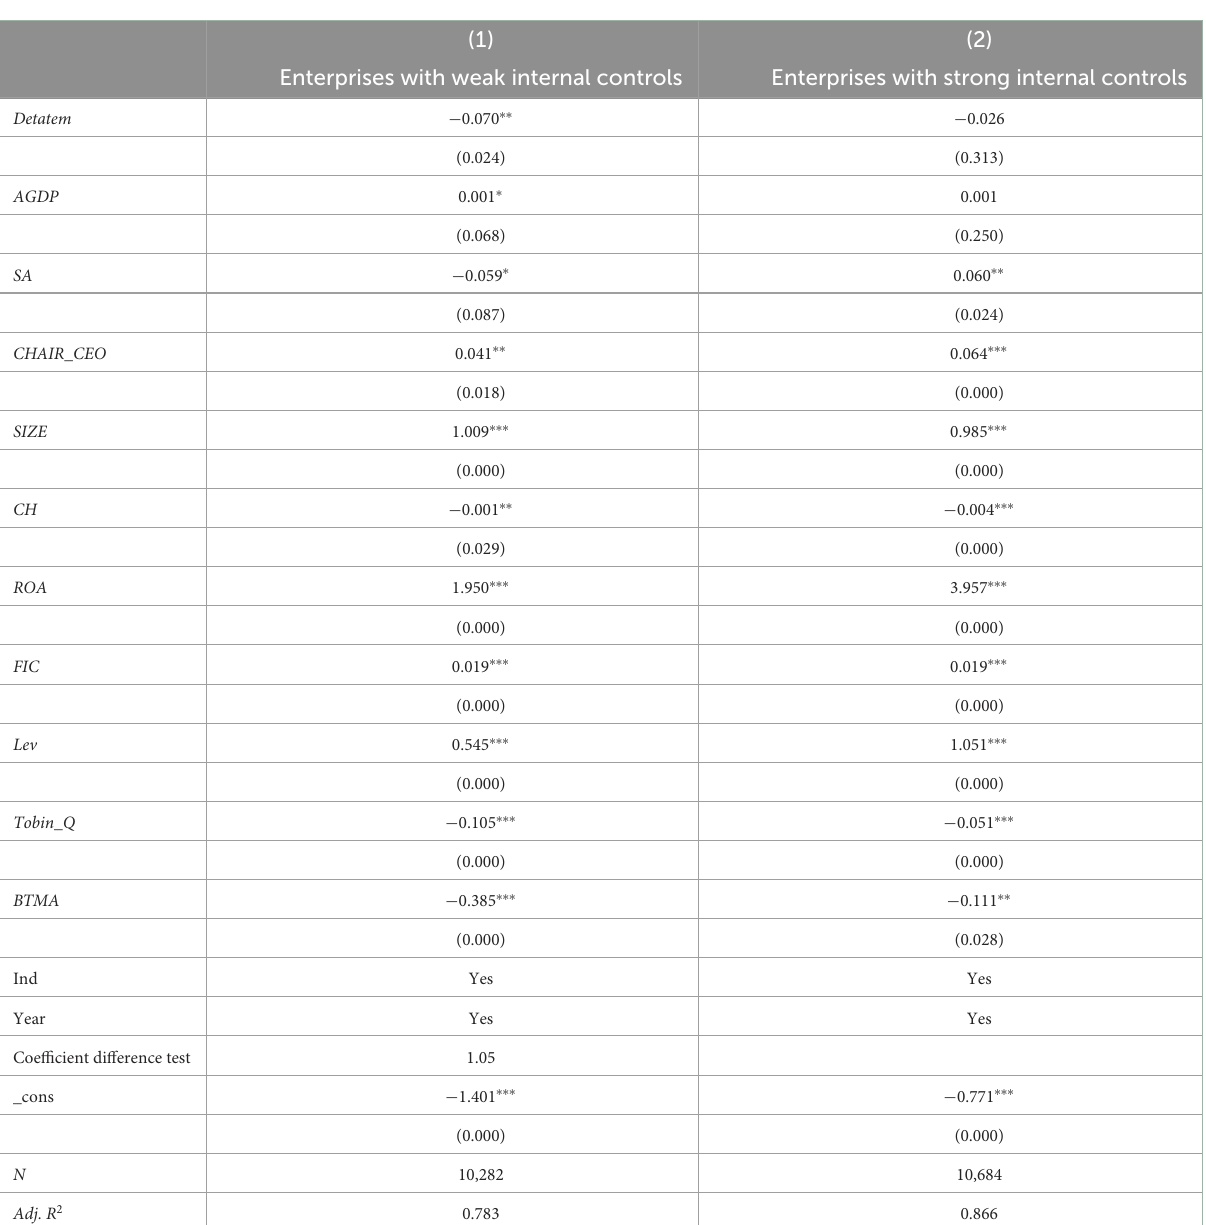
TABLE 11 Climate change, internal controls, and sales revenue. (1) (2) Enterprises with weak internal controls Enterprises with strong internal